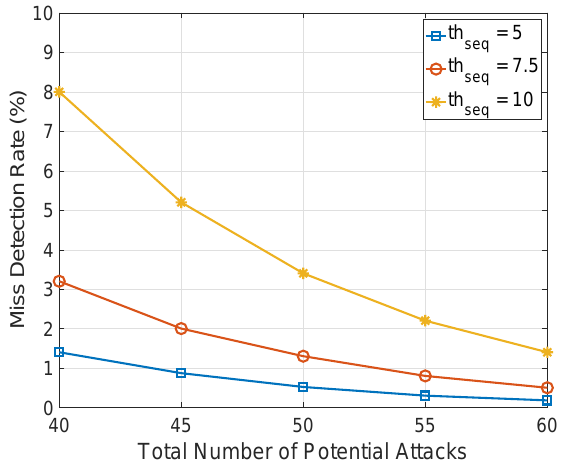
Figure 6. Miss detection rate against the total number of times that the malicious node decides whether to perform suppression